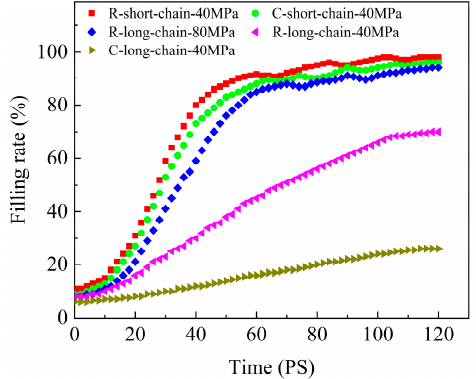
Figure 6. Filling rate of nanostructures during the packing stage.